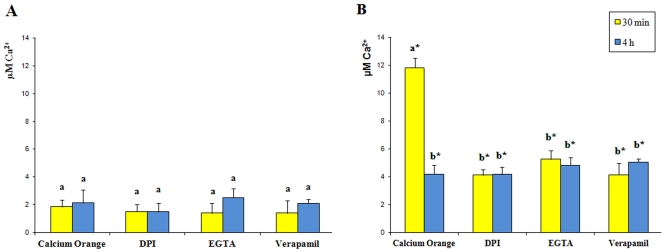
Calcium variations in G. biloba upon mechanical damage and herbivore wounding.
A. Mechanically wounded G. biloba leaves, values (n = 5) are expressed as µM Ca2+ calculated from a calibration curve. The same letter indicates not significant (P>0.05) variation. B. Herbivore wounded G. biloba leaves, values (n = 5) are expressed as µM Ca2+. Different letters indicate significant (P<0.05) differences, the asterisks indicate significant (P<0.05) differences with respect to mechanical damage. In both panels, calcium orange indicates the absence of pharmacological inhibitors.